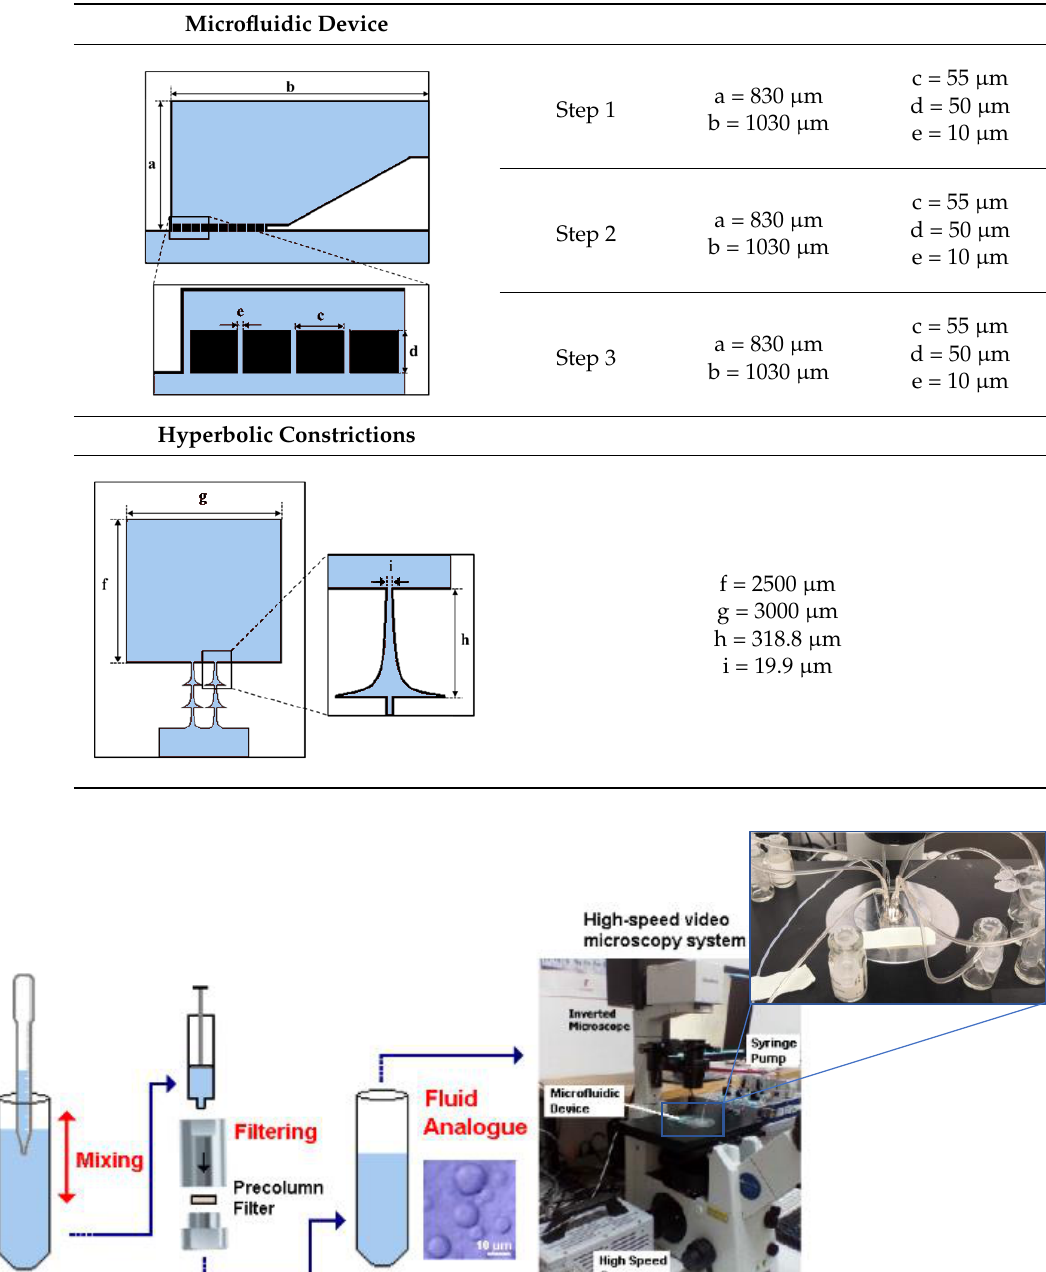
Table 1. Main dimensions of the multi-step crossflow microfluidic device.